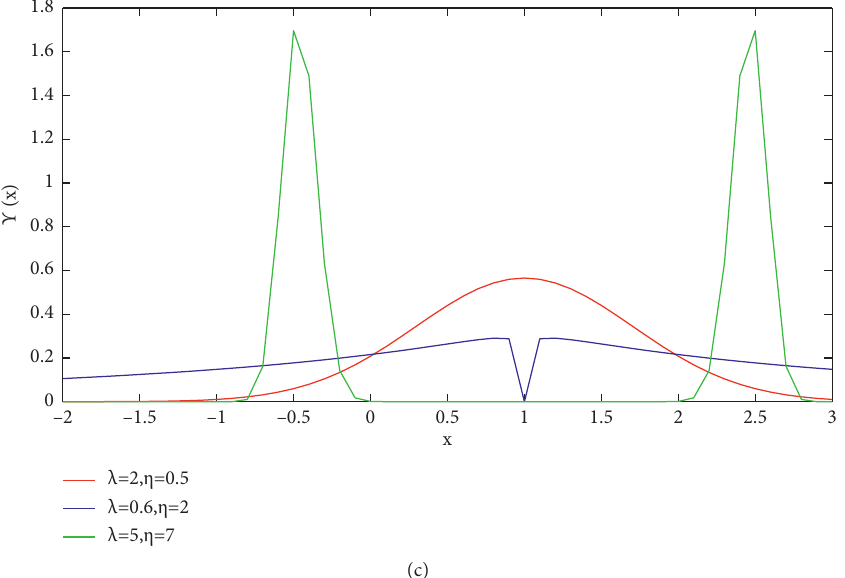
Figure 1: The pdf of B G Γ M for a � − 2, b � 3, u � 1, δ � 1, β � 1 and (a) η � 7 and λ � 2 , 4 , 7; (b) λ � 7 and η � 2 , 4 , 9; (c) ( η � 0 . 5 , λ � 2 ) , ( η � 2 , λ � 0 . 6 ) and ( η � 7 , λ � 5 )